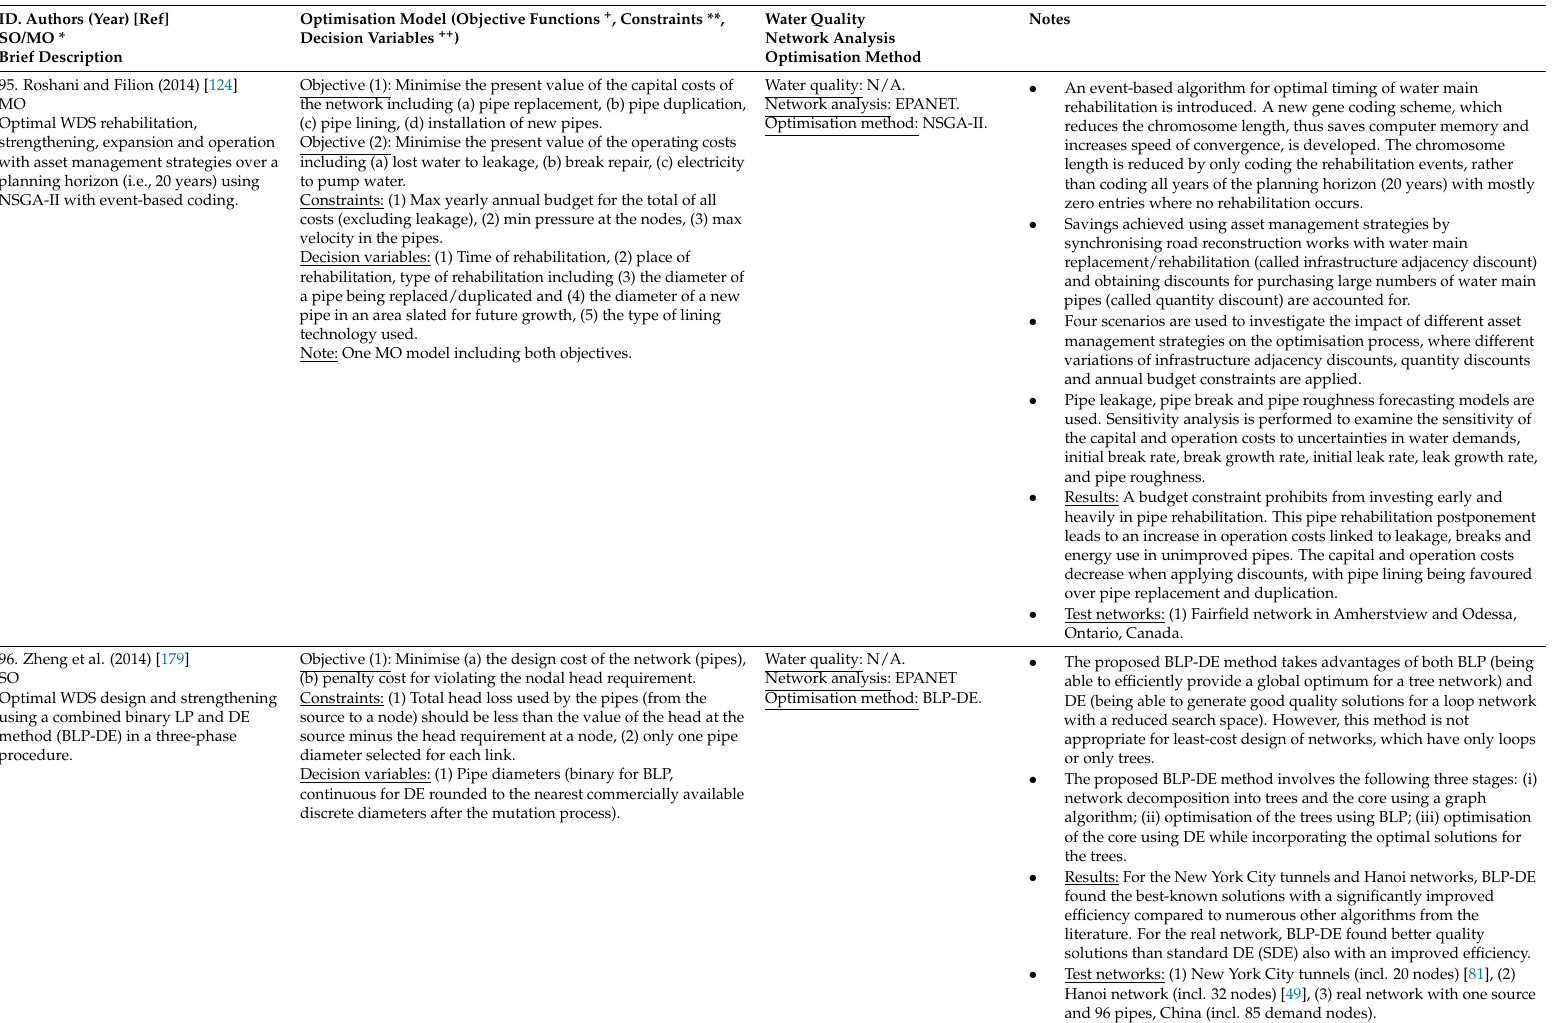
95. Roshani and Filion (2014) [124] MO Optimal WDS rehabilitation, strengthening, expansion and operation with asset management strategies over a planning horizon (i.e., 20 years)